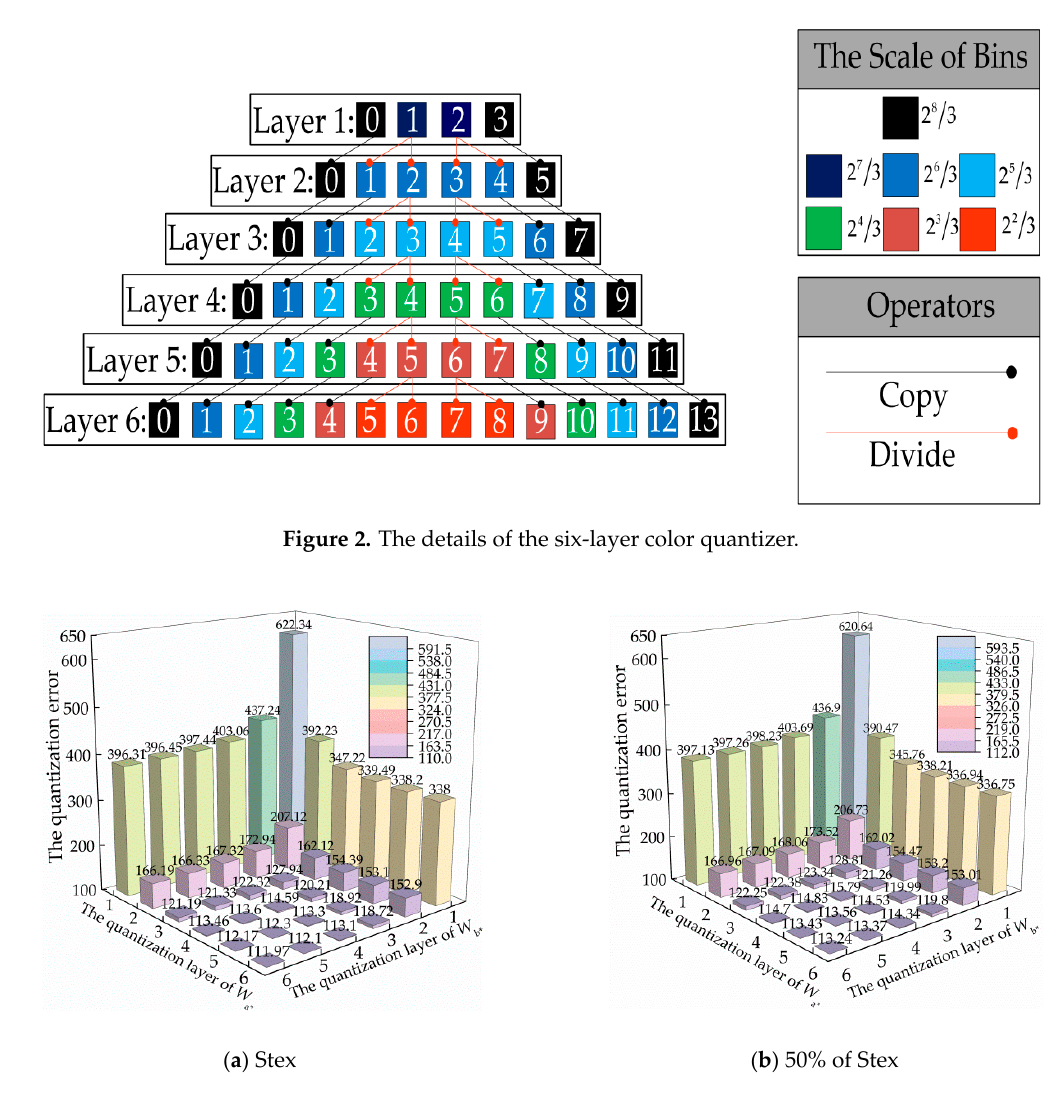
Figure 1. The frequency of pixels on Stex and its subsets: ( a, b ) Stex, ( c, d ) 50% of Stex, and ( e, f ) 10% of Stex.